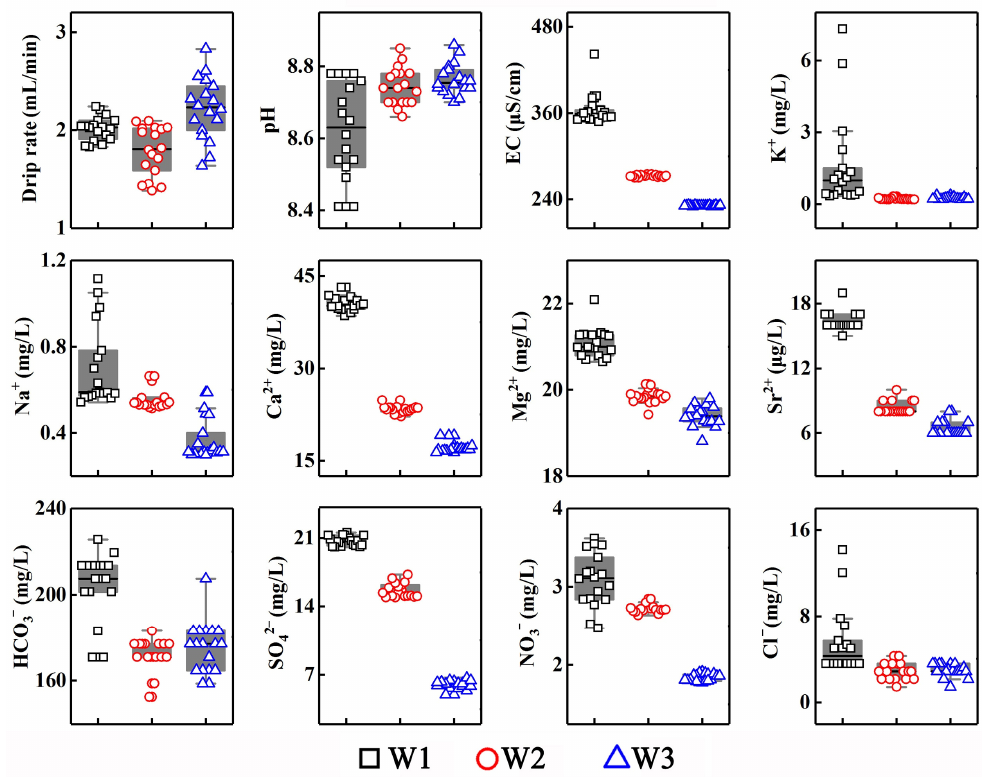
Figure 6. Spatial pattern of drip water hydrogeochemical indicators in the Shijiangjun